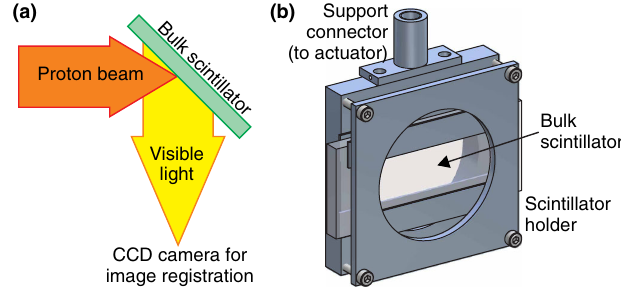
FIG. 1. Calibrated light output and signal-to-noise ratio as a function of beam current for CsI:Tl and SFOP, irradiated with 200 and 50 keV proton beams [13].